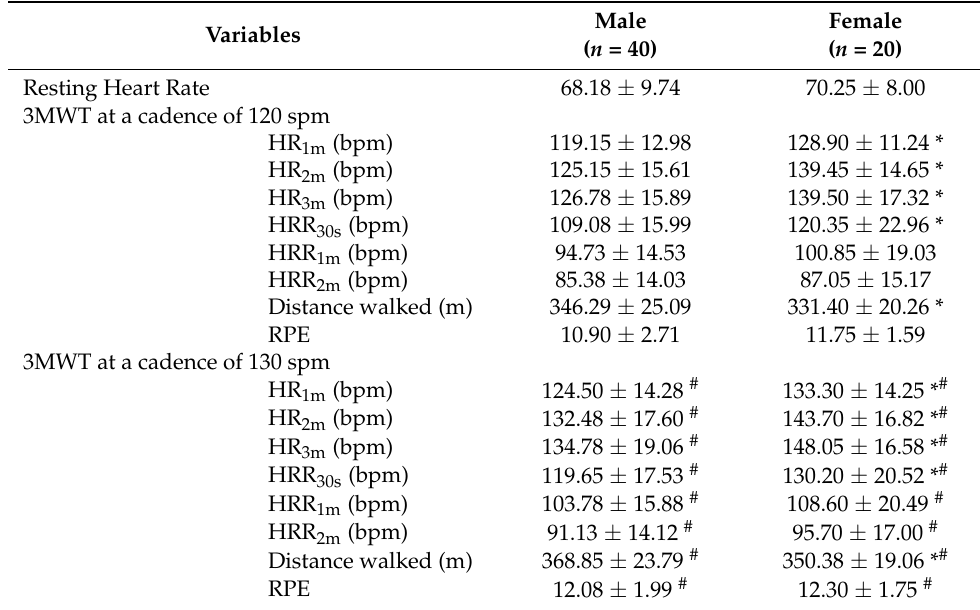
Table 2. Characteristics of the measured exercise related variables.